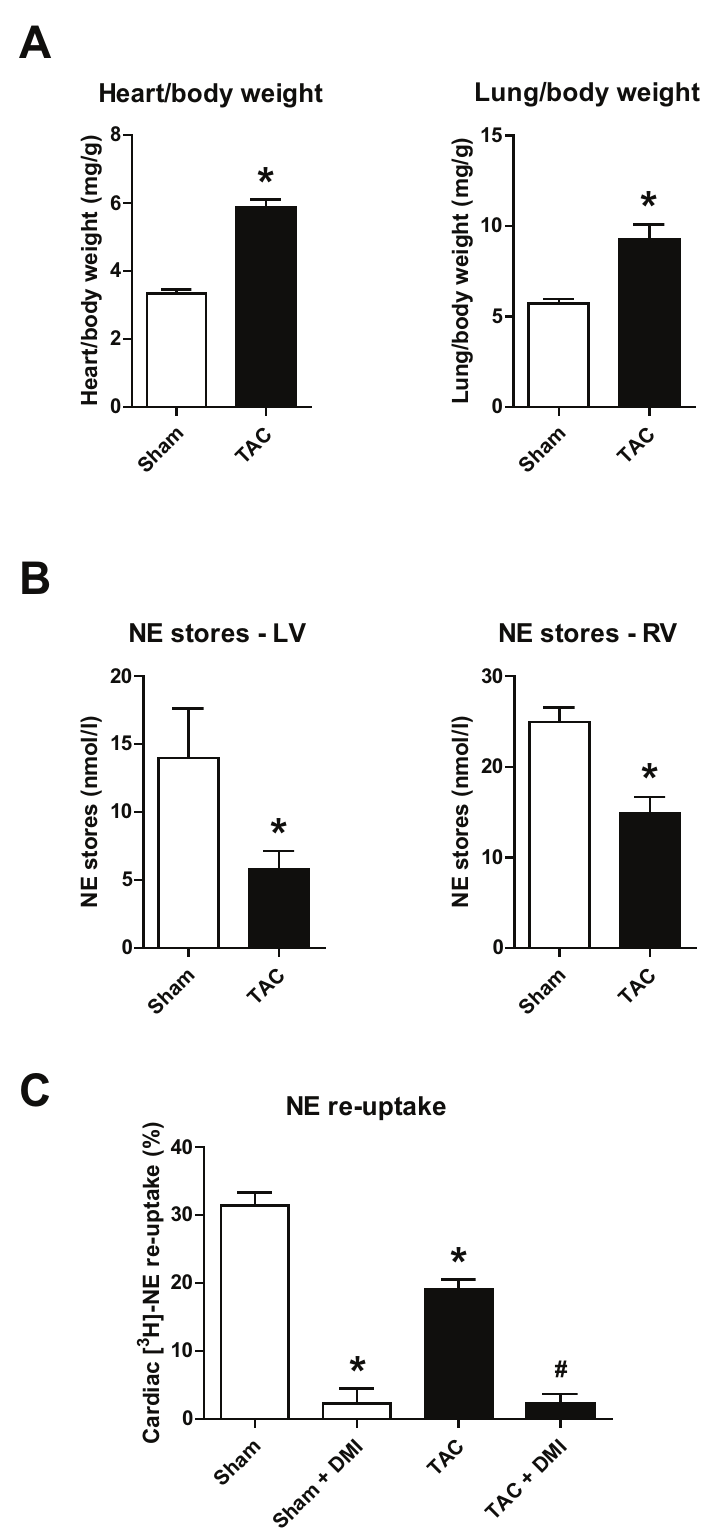
Fig 1. Cardiac norepinephrine (NE) homeostasis after transverse aortic constriction (TAC). (A) Heart weight/body weight ratio as a measurefor cardiac hypertrophy and increasedlung wet weight/body